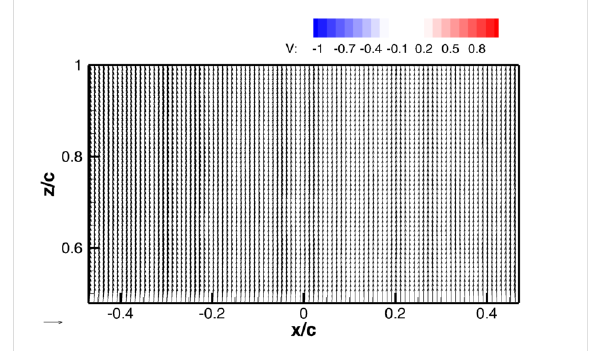
Fig. 8. Mean velocity components distribution, measuring plane 2 .